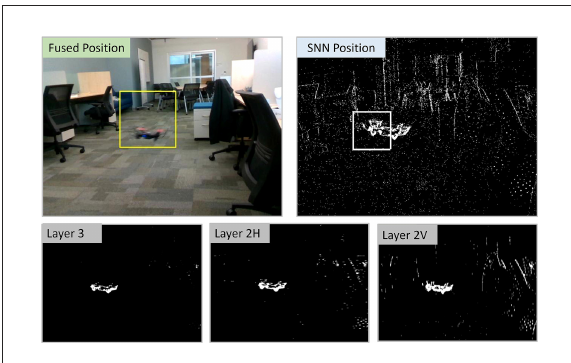
FIGURE9 Screenshots from the processing of the data recorded using the multi-camera assembly. The spiking activity of the intermediate layers of the SNN can be seen to cause self-motion cancelation.